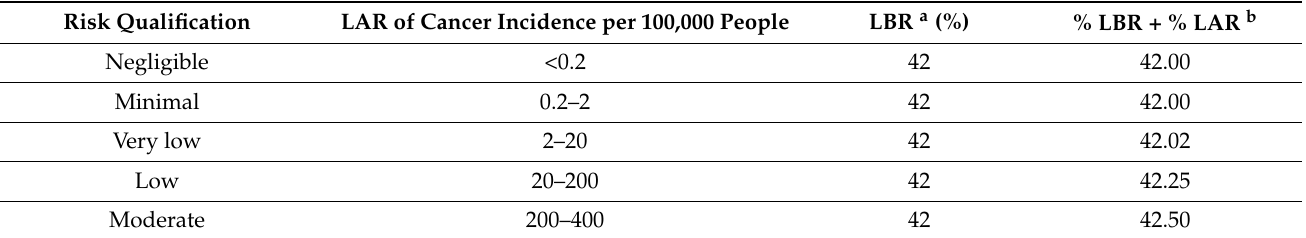
Table 1. A qualitative approach to communicate different levels of cancer incidence associated with radiation exposure compared with the lifetime baseline risk of cancer incidence.